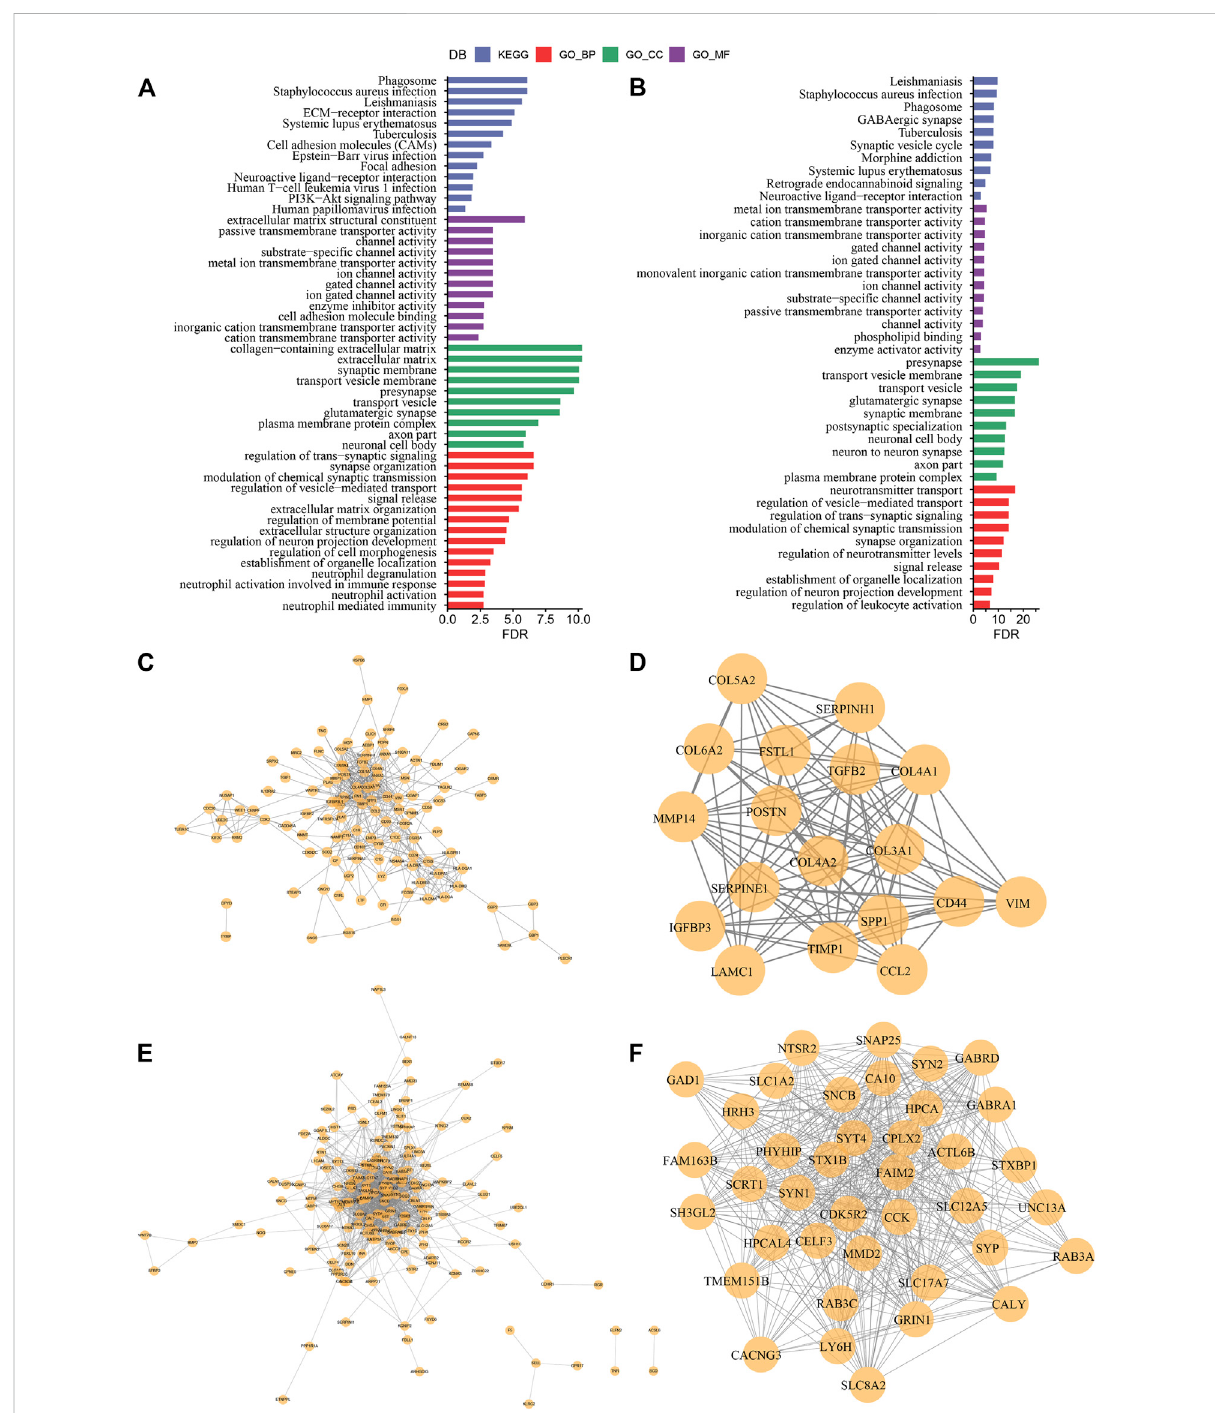
FIGURE 7 Construction of protein interaction network and key module mining (A) Results of GO and KEGG functional enrichment analysis of DEGs in C1subtype; (B) ResultsofGOandKEGGfunctionalenrichmentanalysisofDEGsinC3subtype; (C) PPInetworkofdifferentiallyup-regulatedgenesin C1 subtype; (D) MCODE in PPI network of differentially up-regulated genes in C3 subtype key clusters identi fi ed by the plug-in; (E) PPI network of differentially down-regulated genes in C1 subtype; (F) Key clusters identi fi ed by the MCODE plug-in in PPI network of differentially down- regulated genes in C3